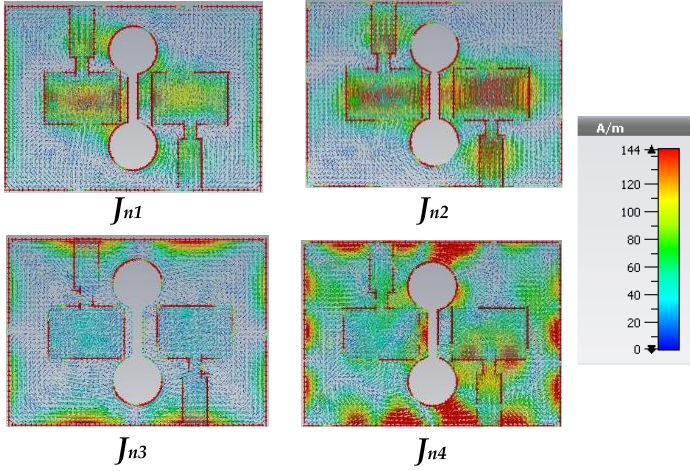
Figure 16. Model current distribution of Ant. C with the MTM unit cell.